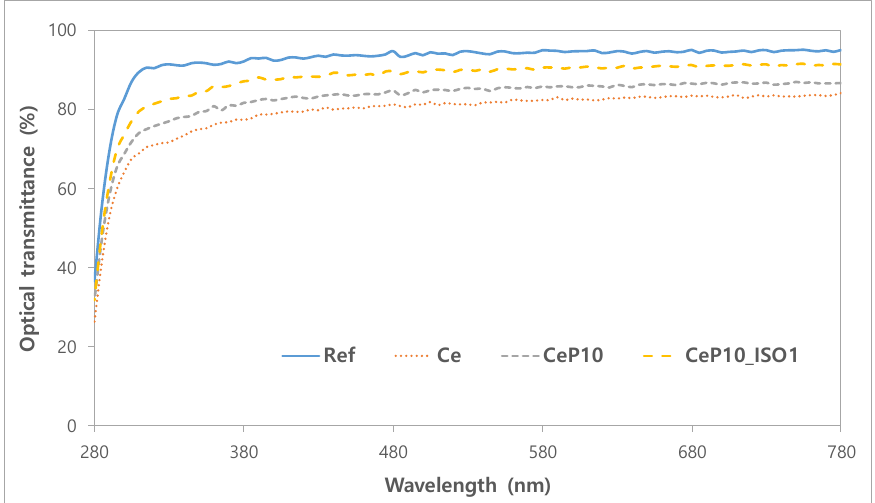
Figure 2. Optical transmittance of samples.